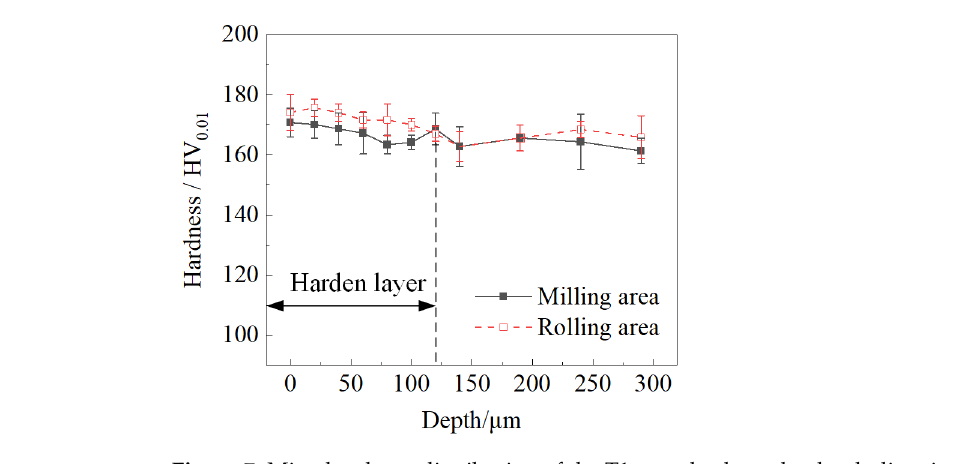
Figure 7. Microhardness distribution of the T1 sample along the depth direction after rolling correc- tion treatment.